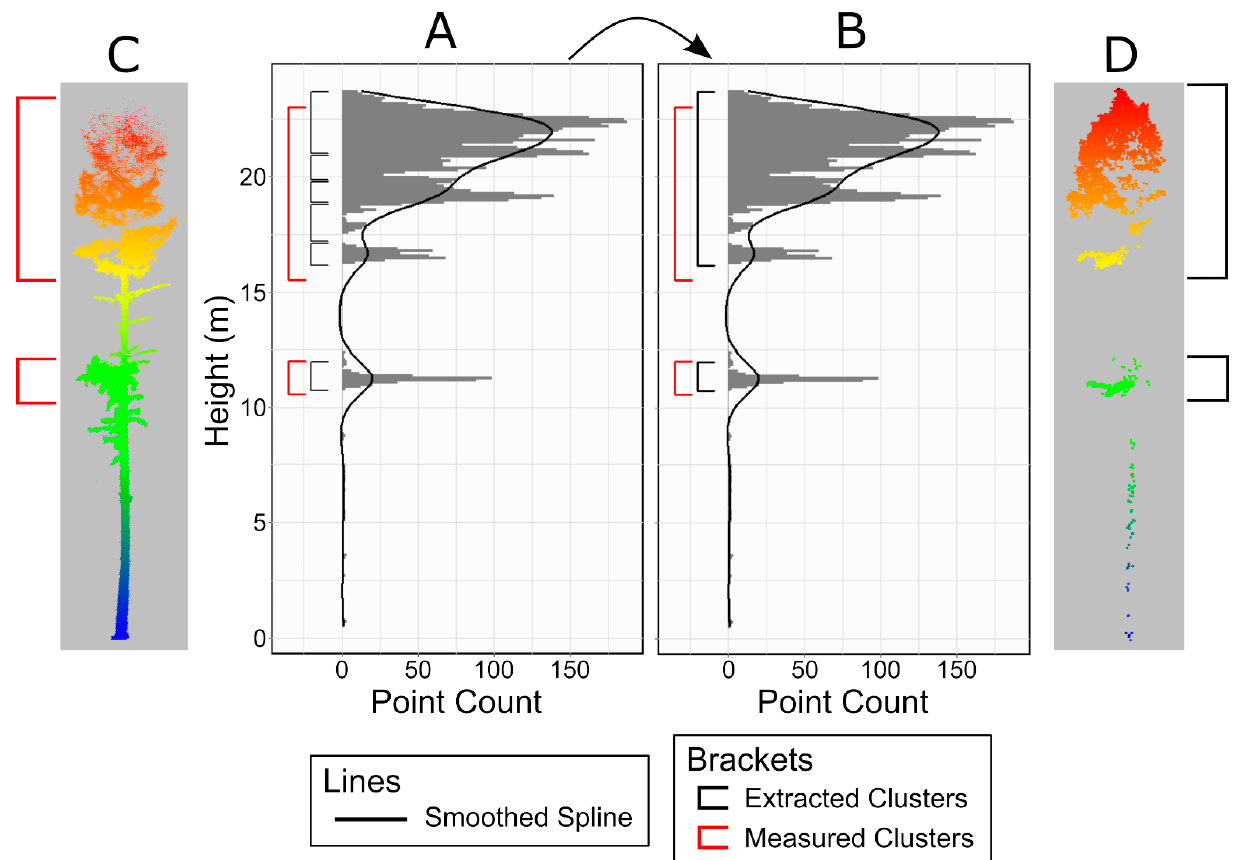
Figure 5. Examples of manually measured live branch clusters compared to extracted clusters before and after cluster aggregation. ( A ) Histogram showing validation data compared to automatically extracted live branch clusters; ( B ) histogram showing validation data compared to extracted live branch clusters following their aggregation; ( C ) MLS point cloud with measured clusters; ( D ) thinned RPAS LiDAR point cloud with aggregated extracted clusters.